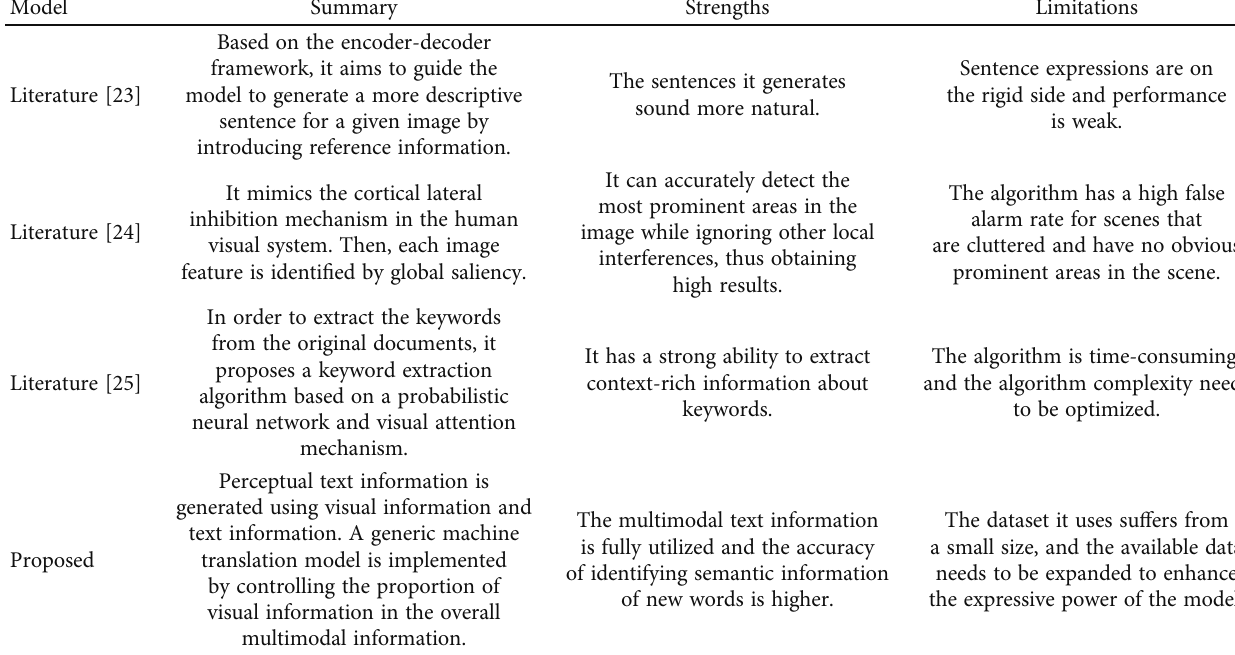
Table 3: Summary of comparative